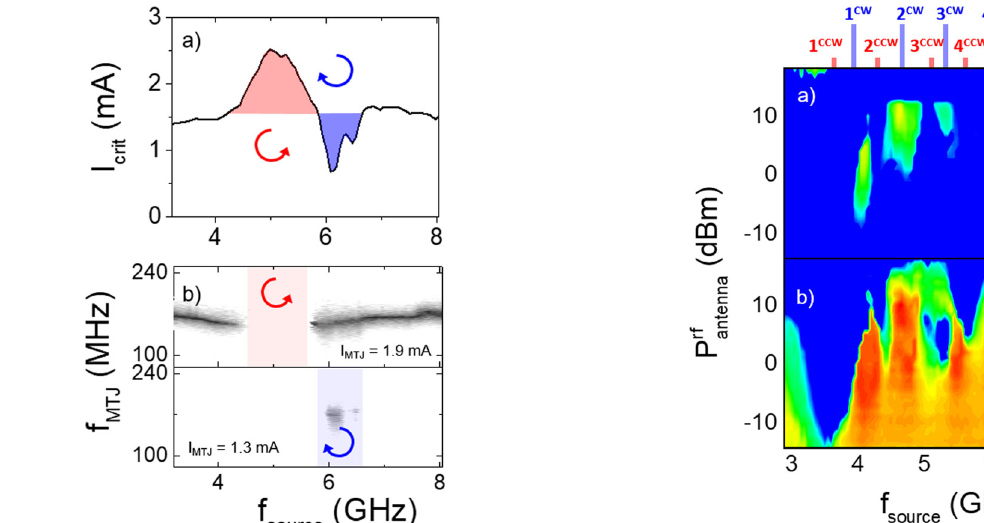
Fig. 6 Gyrotropic critical current modi fi ed by higher-order mode excitation. a Critical current, I crit , necessary to observe gyrotropic motion and b example spectra showing measured frequency, f MTJ , vs. excitation frequency, f source , for a super-critical ( I MTJ = 1.9 mA) and a sub-critical ( I MTJ = 1.3 mA) dc current of a magnetic tunnel junction, MTJ, with diameter d = 300 nm. The circular arrows indicate the sense of propagation of the spin-wave mode.